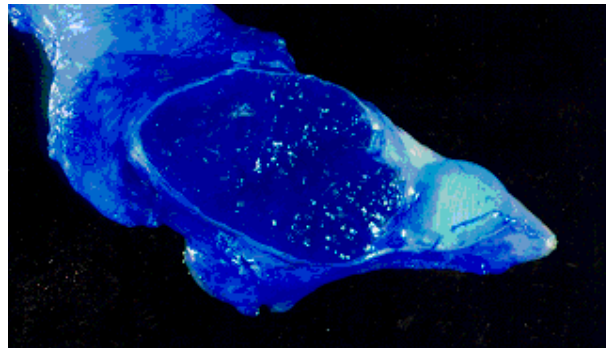
FIGURE 1C . Splenogonadal fusion, discontinuous type. The larger splenic mass (2.4 x 1.4 cm) lies superior to the smaller nubbin of testicular tissue (0.8 x 0.7).